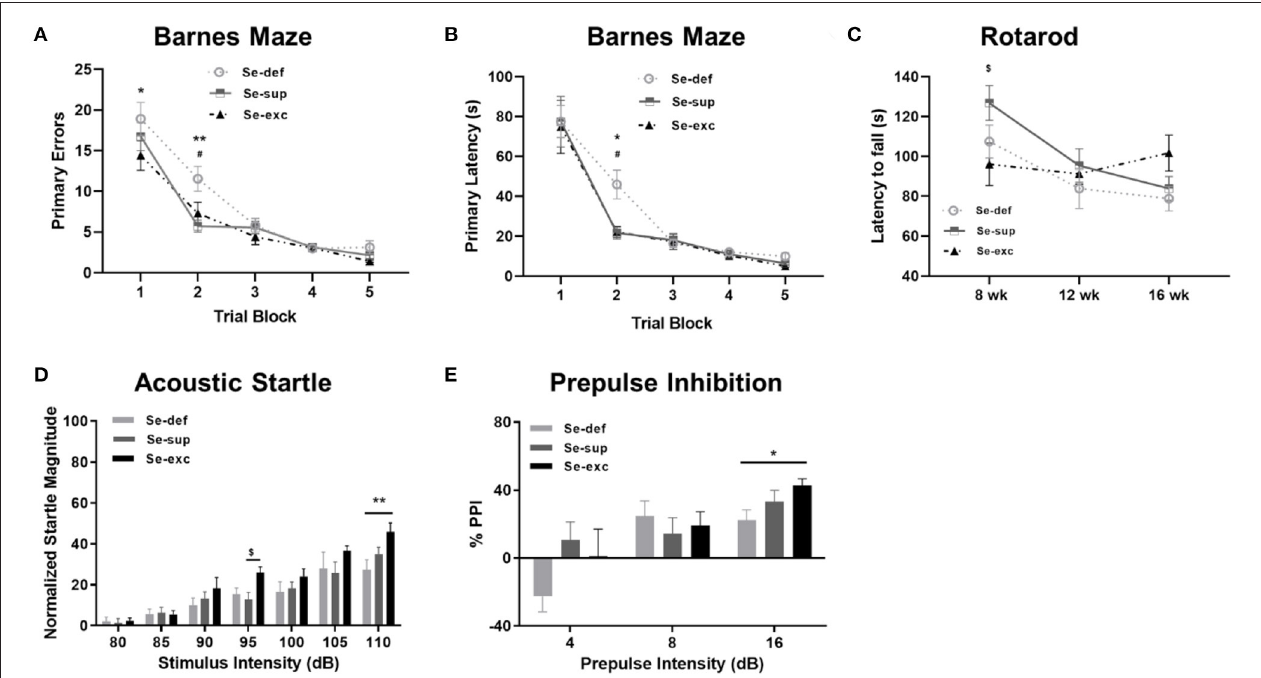
FIGURE 2 | Se-deficient mice exhibit deficits in cognition and sensorimotor gating. (A) Mean ( ± SEM) number of incorrect holes checked before locating the escape tunnel during Barnes maze training. (B) Mean ( ± SEM) latency to locate the escape tunnel during maze training. (C) Mean ( ± SEM) latency to fall off the Rotarod at 8, 12, and 16 weeks of age. (D) Mean ( ± SEM) normalized startle magnitude as a function of acoustic startle intensity. (E) Mean ( ± SEM) percentage of prepulse inhibition as a function of prepulse intensity above the background level (70 dB). $ p < 0.05 between Se-exc and Se-sup groups; * p < 0.05 between Se-exc and Se-def groups; ** p < 0.01 between Se-exc and Se-def groups; # p < 0.05 between Se-def and Se-sup groups ( n = 9–10 animals per group for all